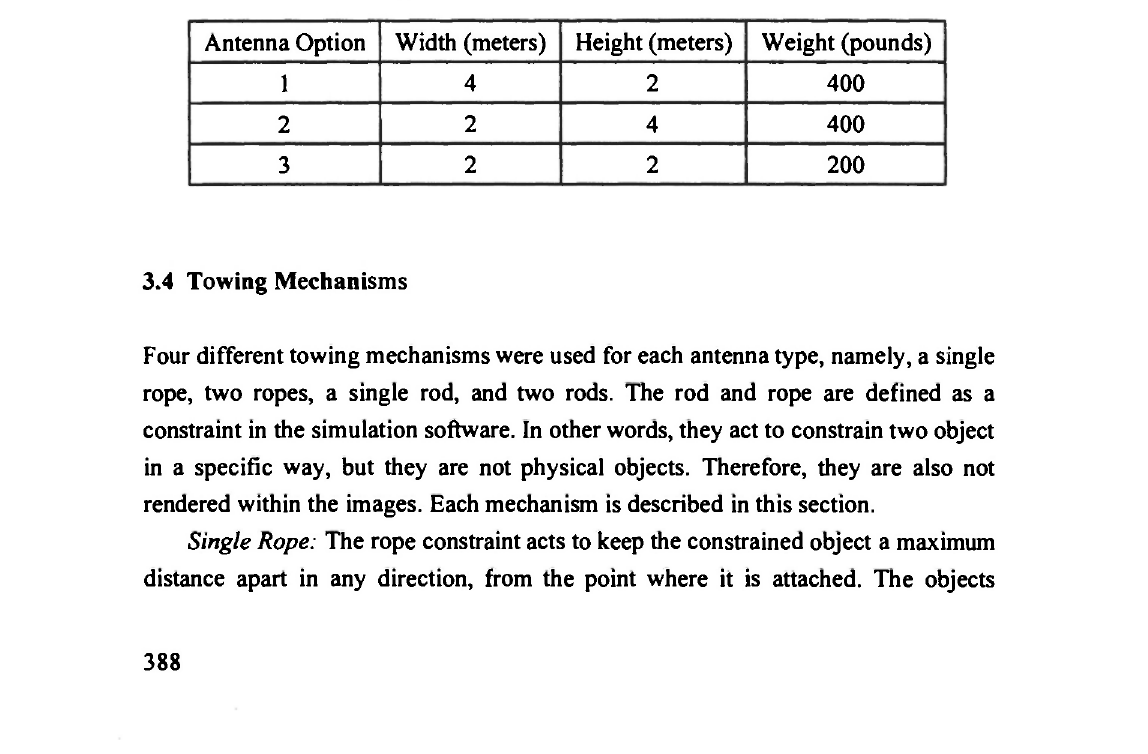
Specifications for the three